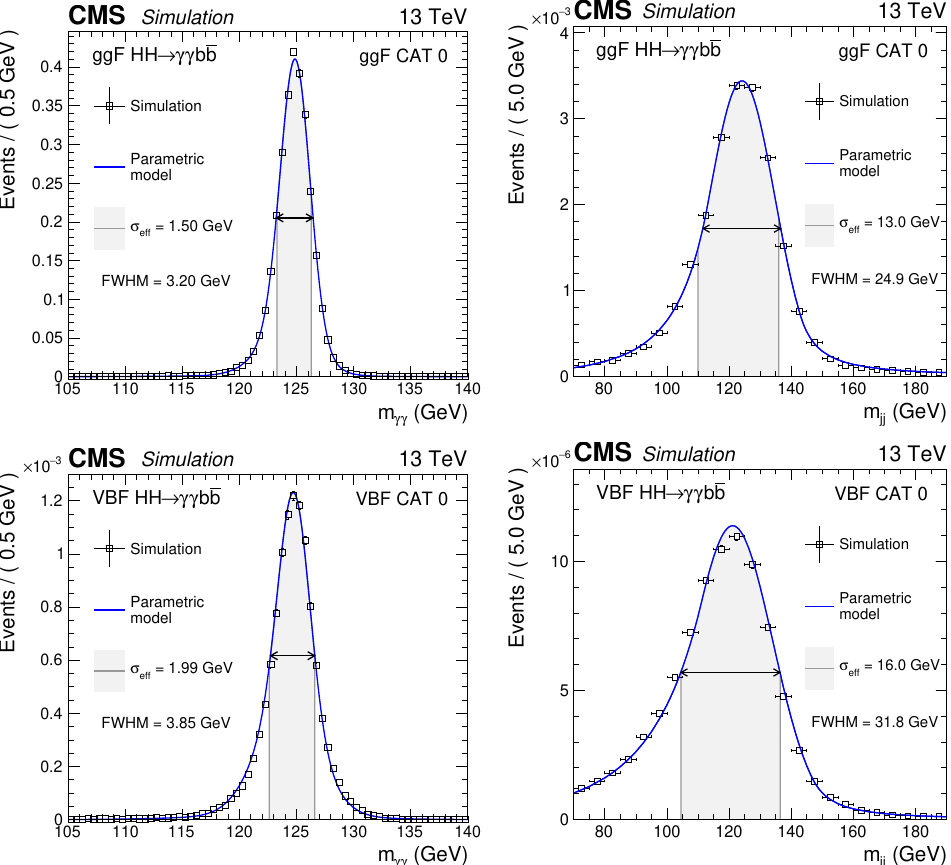
(left) and m (right) in the best resolution ggF γγ jj value (half the width of the narrowest eff